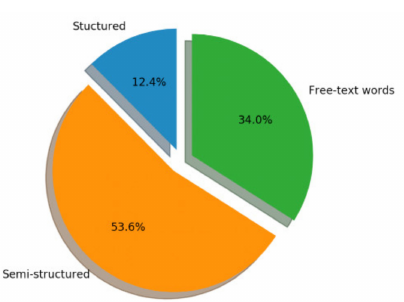
Figure 3. Distribution of the sizes of different data